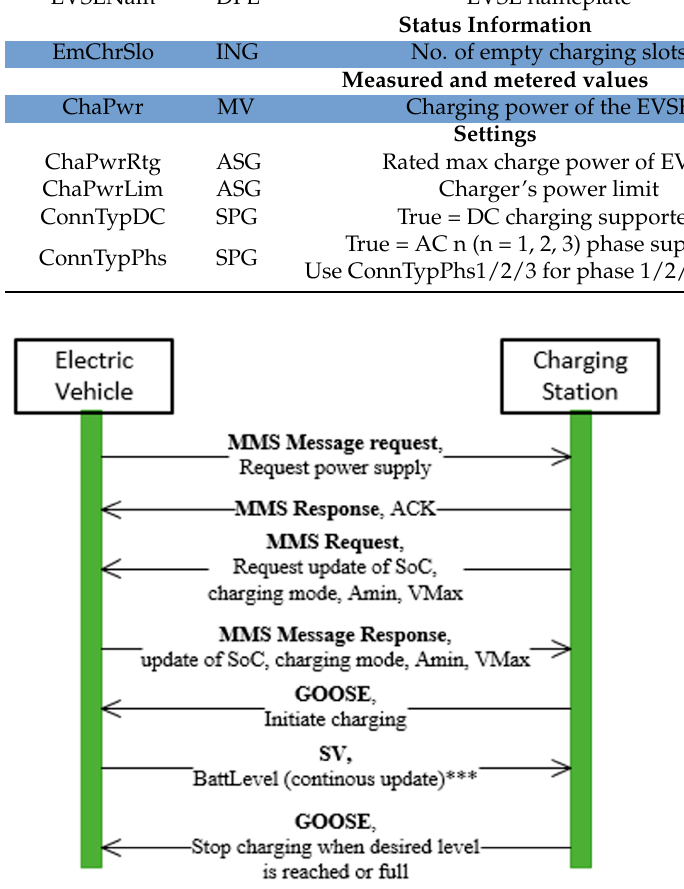
Figure 2. Sequence of message exchanges between EVs and CSs.